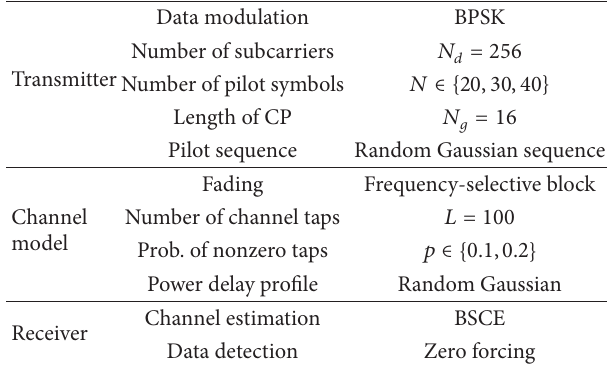
Table 2: Simulation parameters.